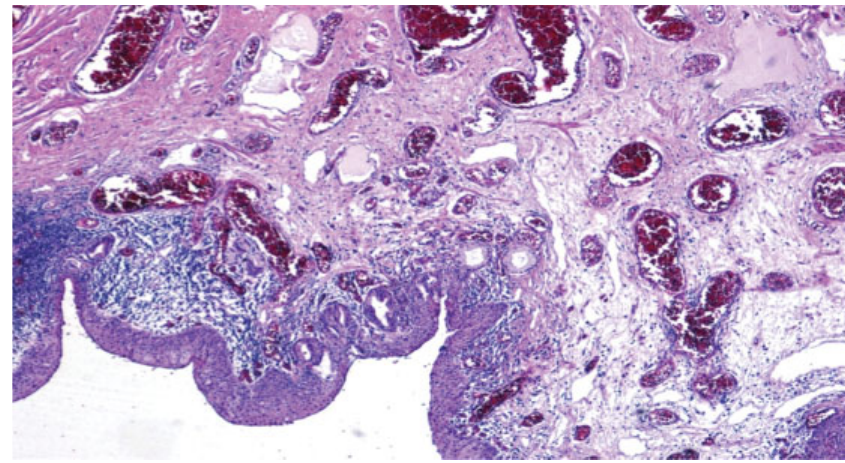
Fig. 2 Pathologic specimen of dorsal urethral